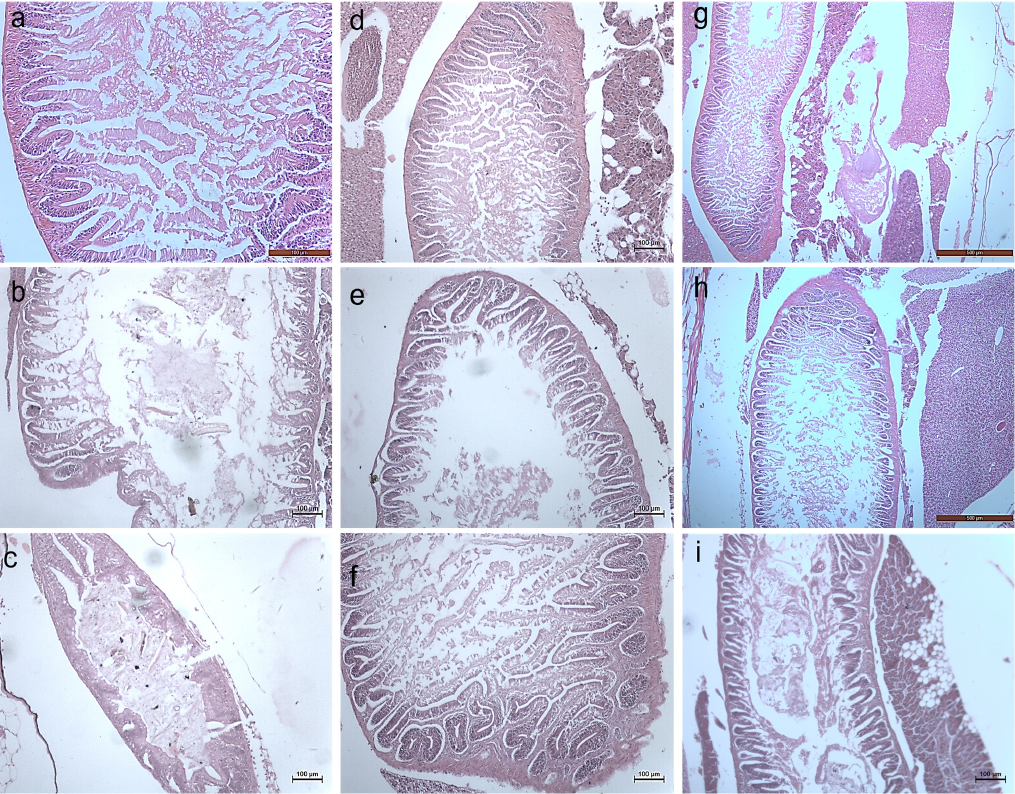
Figure 16. Histology images of intestines of Zebrafish— Danio rerio (10X Magnification) ( a ) 10th day control, ( b ) exposed to 10 µg at 10th day, ( c ) exposed to 20 µg at 10th day; ( d ) 20th day control, ( e ) exposed to 10 µg at 20th day, ( f ) exposed to 20 µg at 20th day; ( g ) 30th day control, ( h ) exposed to 10 µg at 30th day, ( i ) exposed to 20 µg at 30th day.